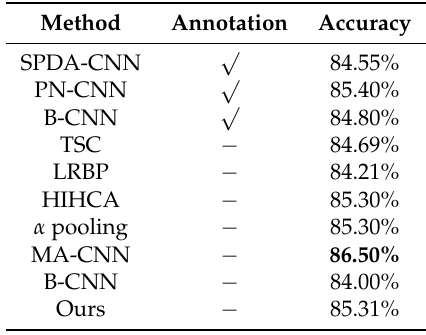
Table 6. Comparison with previous methods on